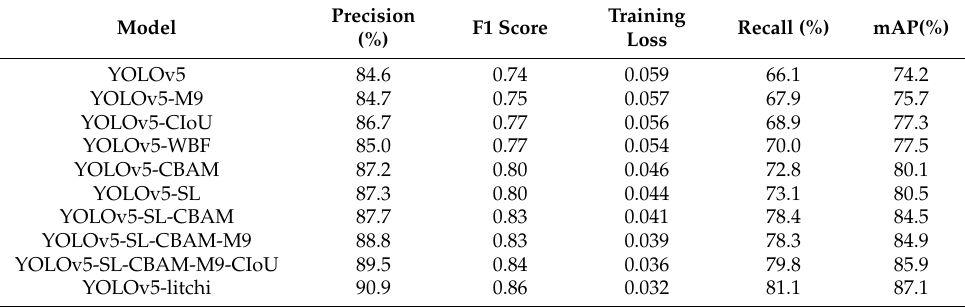
Table 2. Comparison of the ablation